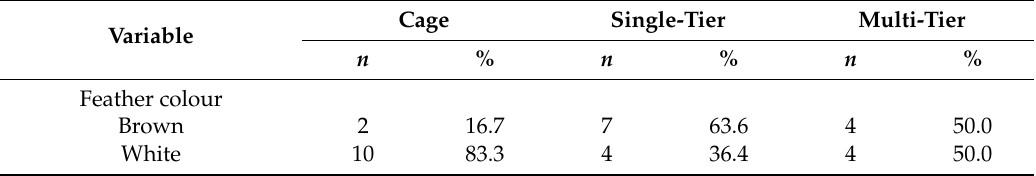
Table 6. Frequency of flock characteristics for 33 pullet flocks placed between May and November